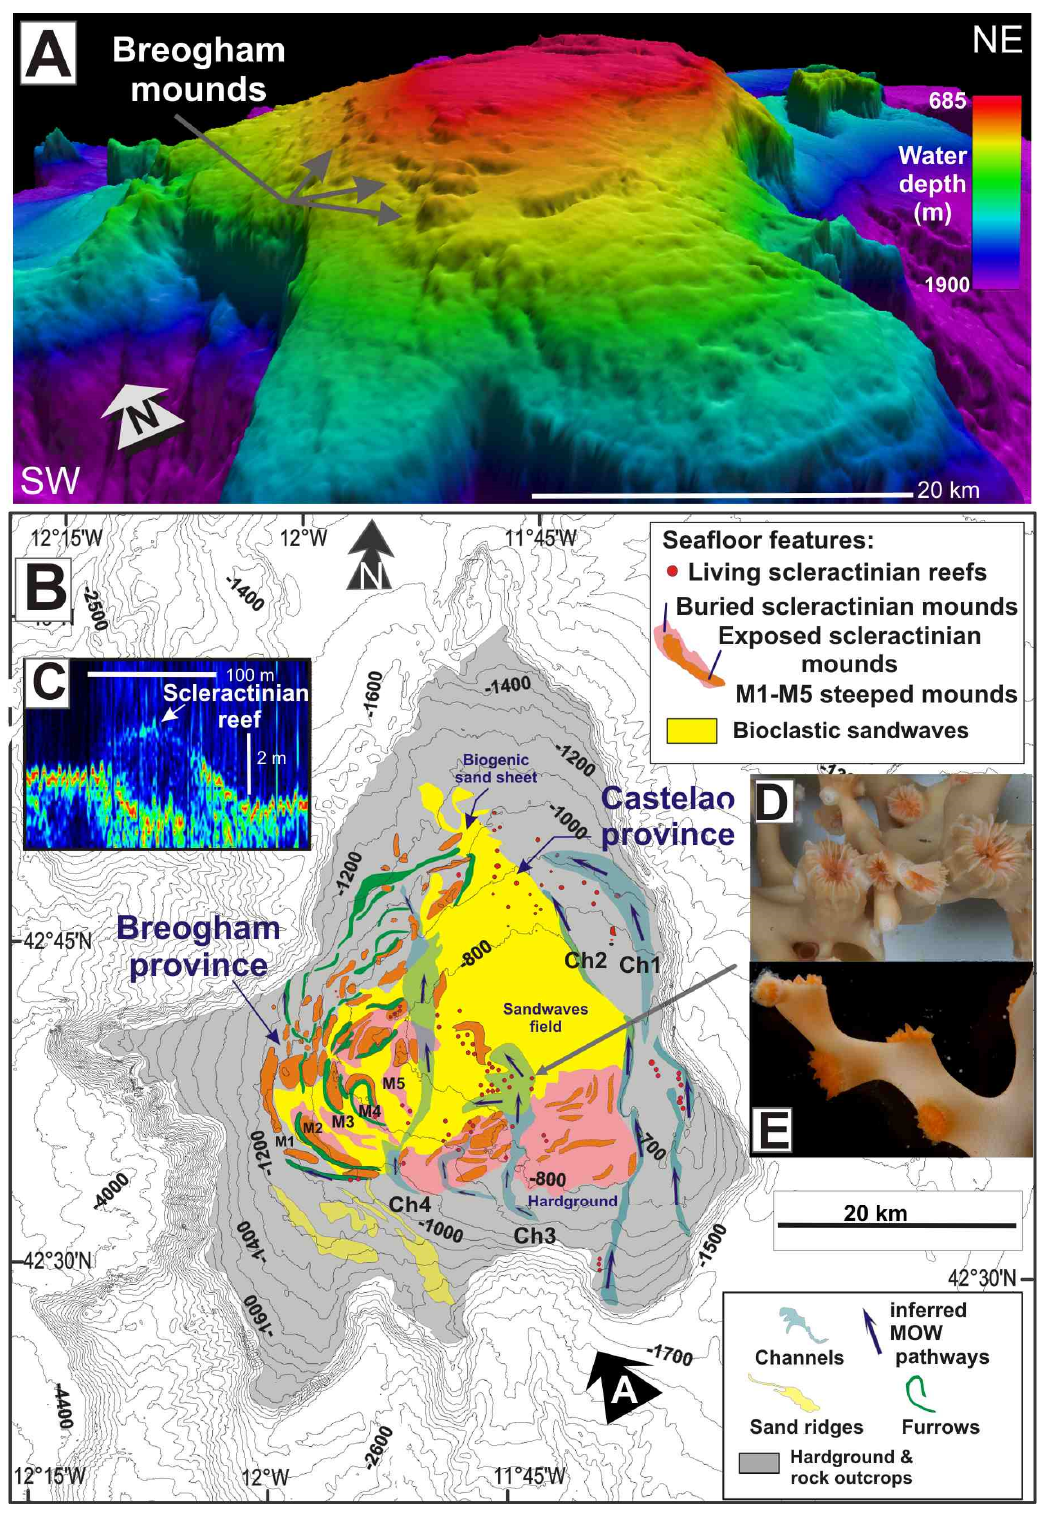
Figure 3. Seabed distribution of scleractinian reefs and mounds (M) in the Galicia Bank: ( A ) 3D shaded relief model using multibeam bathymetry data; Sunlight from the NW; ( B ) Morphological map including morpho-sedimentary features and scleractinian reefs identified with multibeam and backscatter data; ( C ) Ultra high-resolution sub-bottom profile crossing scleractinian reefs were ( D , E ) living Desmophyllum pertusum and Madrepora oculata appear .